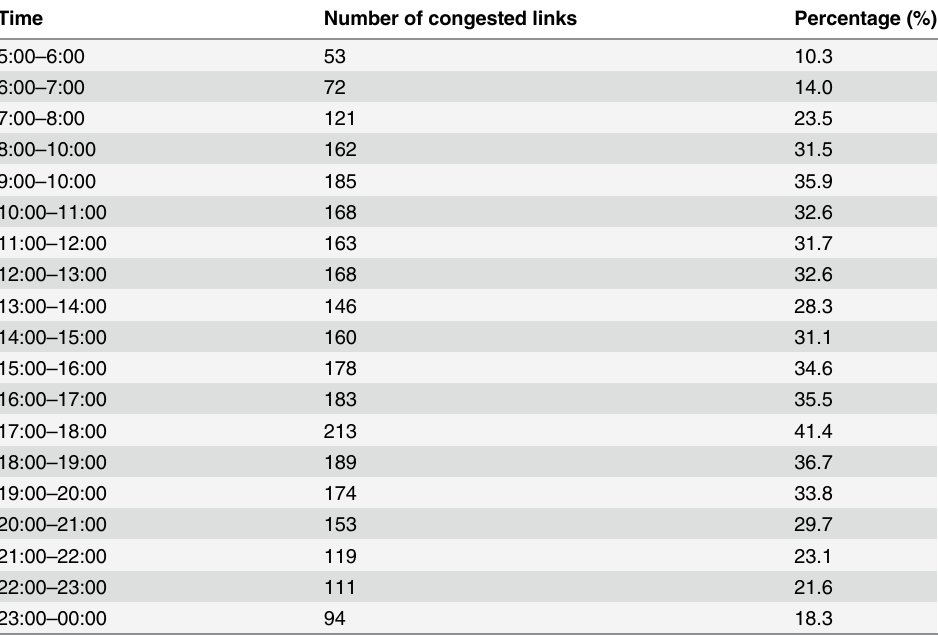
Table 2. Statistics for number of congested links on May 9, 2014. Time Number of congested